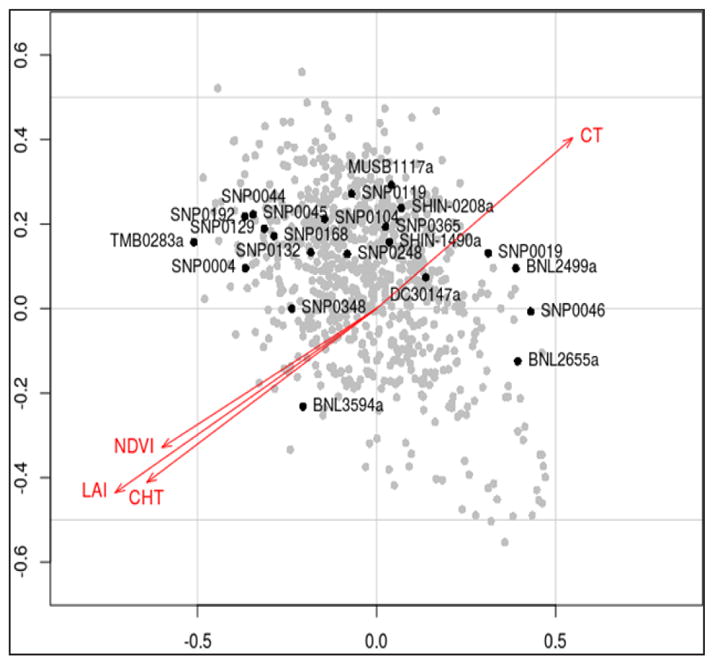
Partial Least Square Regression: correlation biplot; showing trait components in red, and marker components in gray and black (significantly associated markers). Within traits, negative correlations for LAI, NDVI, CHT, and positive correlation for CT were detected.